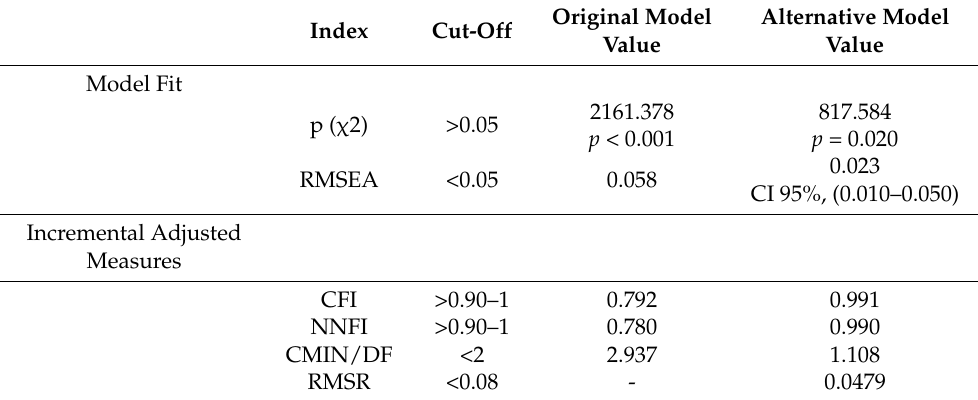
Table 2. My Children’s Play goodness-of-fit index from the confirmatory factor